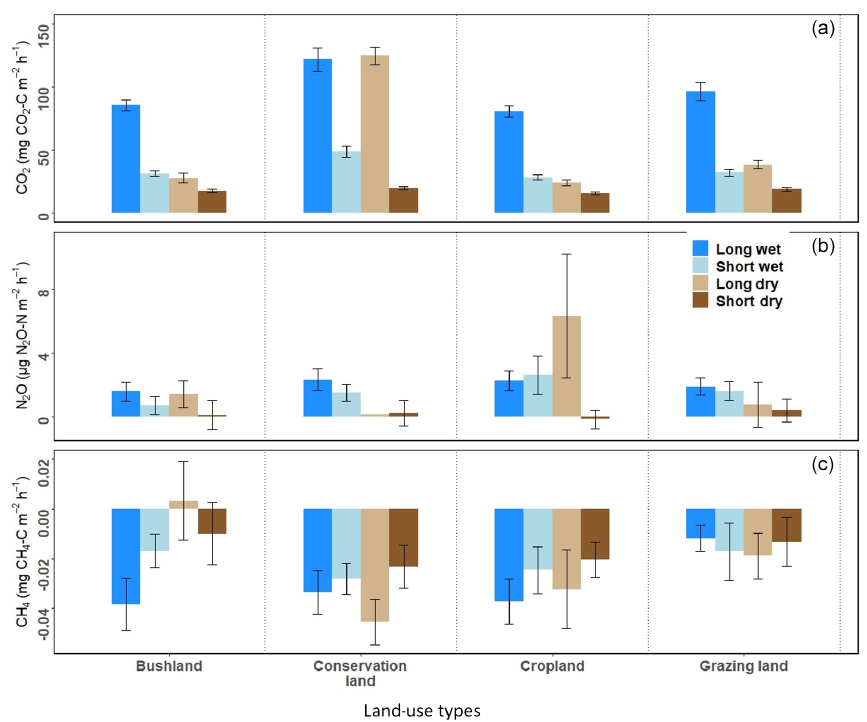
Figure 5. Seasonal differences in mean (a) CO 2 , (b) N 2 O, and (c) CH 4 emissions between the long and short wet seasons and the long and short dry seasons for the four land-use